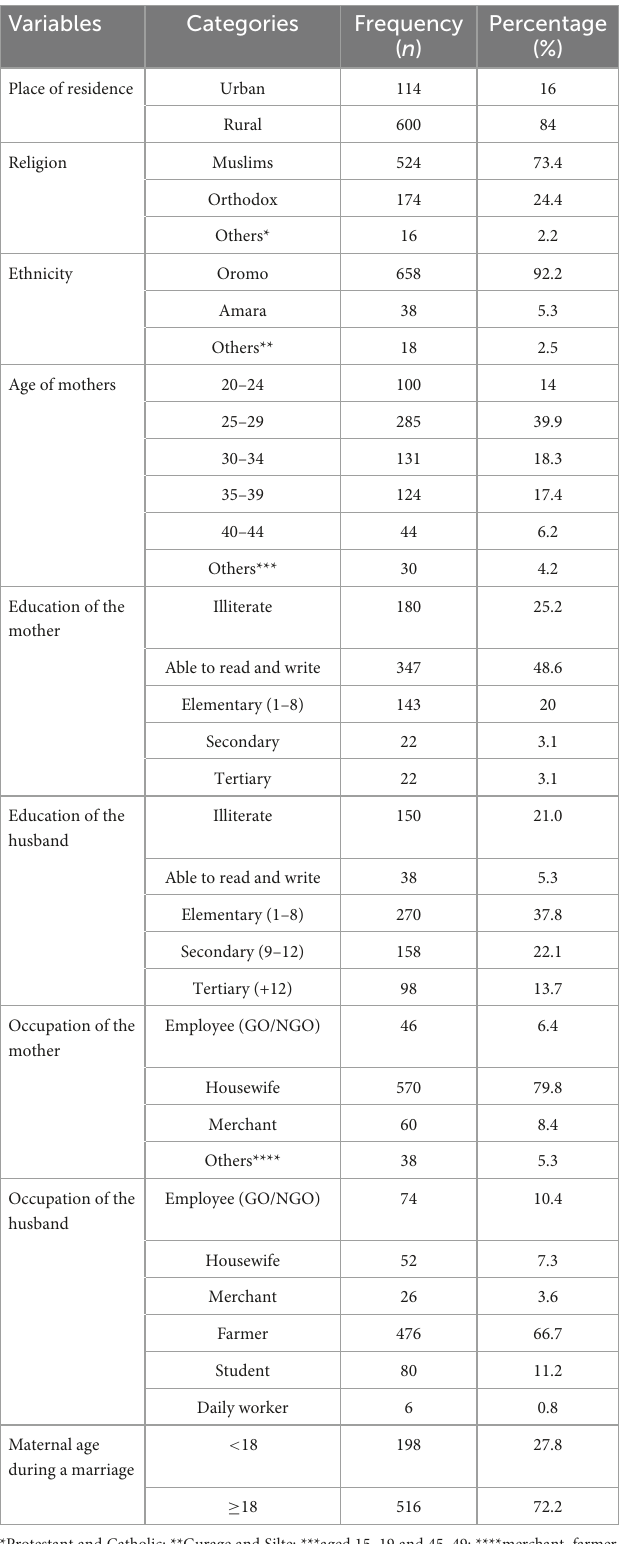
TABLE 1 Sociodemographic characteristics of the respondents in the Gedeb Hasasa district of the West Arsi zone, Ethiopia ( N = 714). Variables for mothers was 36 months for the last two succeeding births.